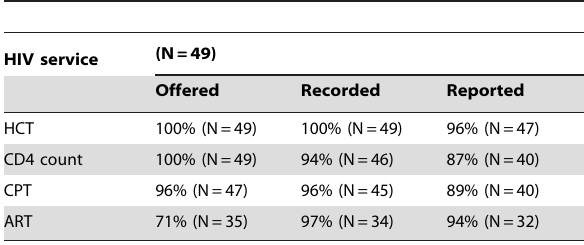
Table 3. Recording and reporting of HIV services in selected sites (N =49) in South Africa, March